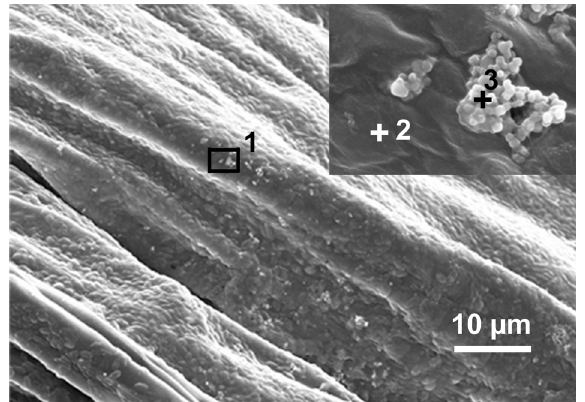
Fig 2. Scanning electron microscopy image of dried red clover root. Root surface from a 24 mg l -1 E171 treated plant is shown. The insert shows a magnification of 1, and from the spots 2 and 3 (+) X-ray fluorescence spectra were prepared revealing that spot 2 did not contain titanium while spot 3 contained titanium.